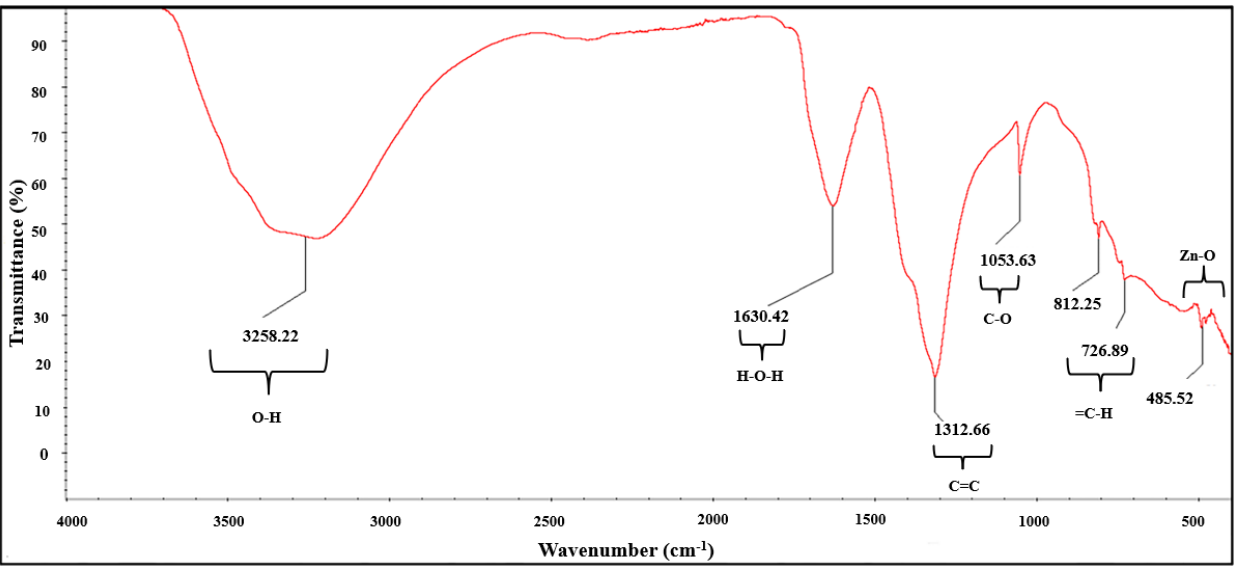
Figure 5. FTIR spectrum of synthesized Zinc oxide nanoparticles.